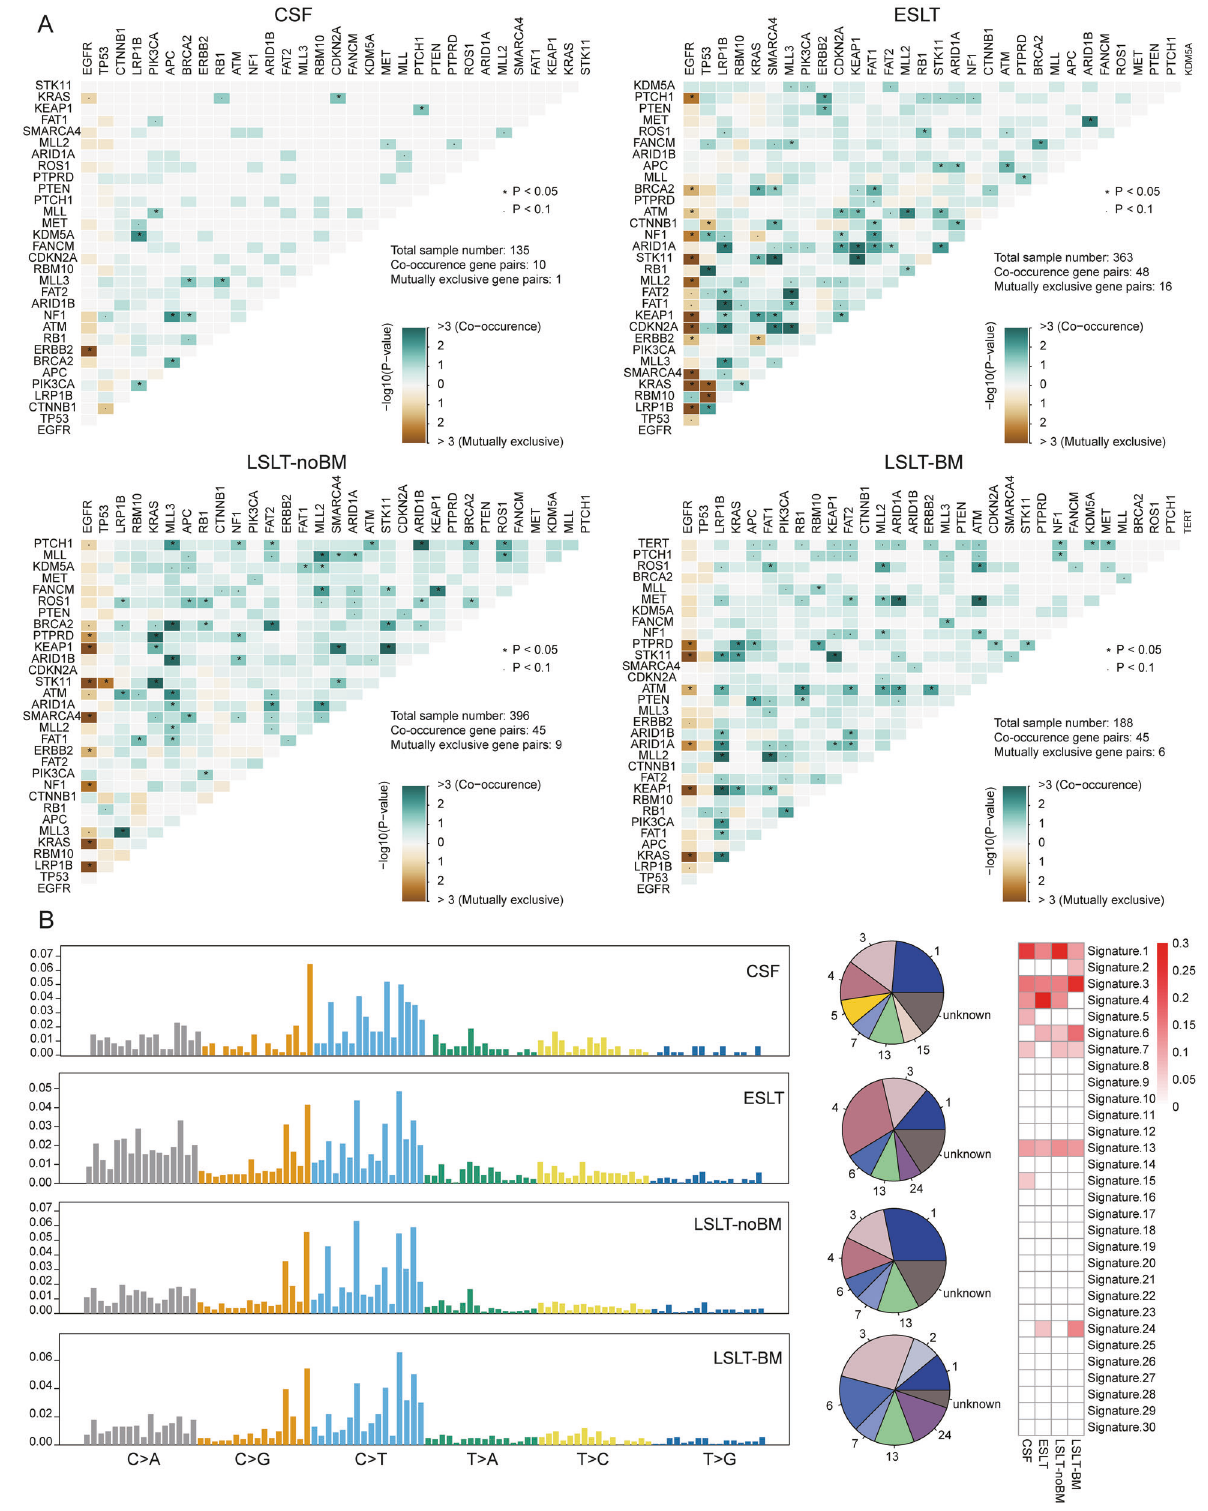
Fig. 3 Mutational relationships and processes based on CSF and primary lung tumors. A Co-occurrence and mutually exclusivity analyses of somatic mutation genes in CSF and lung tissue. Fisher ’ s exact test was used to identify remarkable interactions. * P < 0.05. B The somatic mutation signature analysis. From left to right: the mutation distribution pro fi le of tumor samples and the vertical axis represents the number of mutations for each triple nucleotide type, proportion of total somatic substitutions in four groups contributed by each of the operative mutational signatures, the heatmap distribution of signatures in all